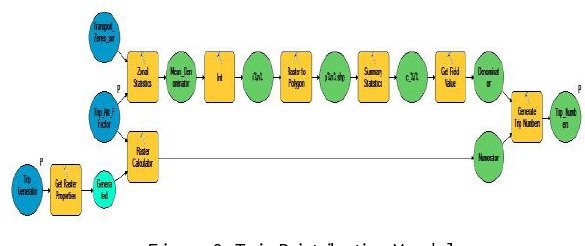
Figure 9. Trip Distribution Model